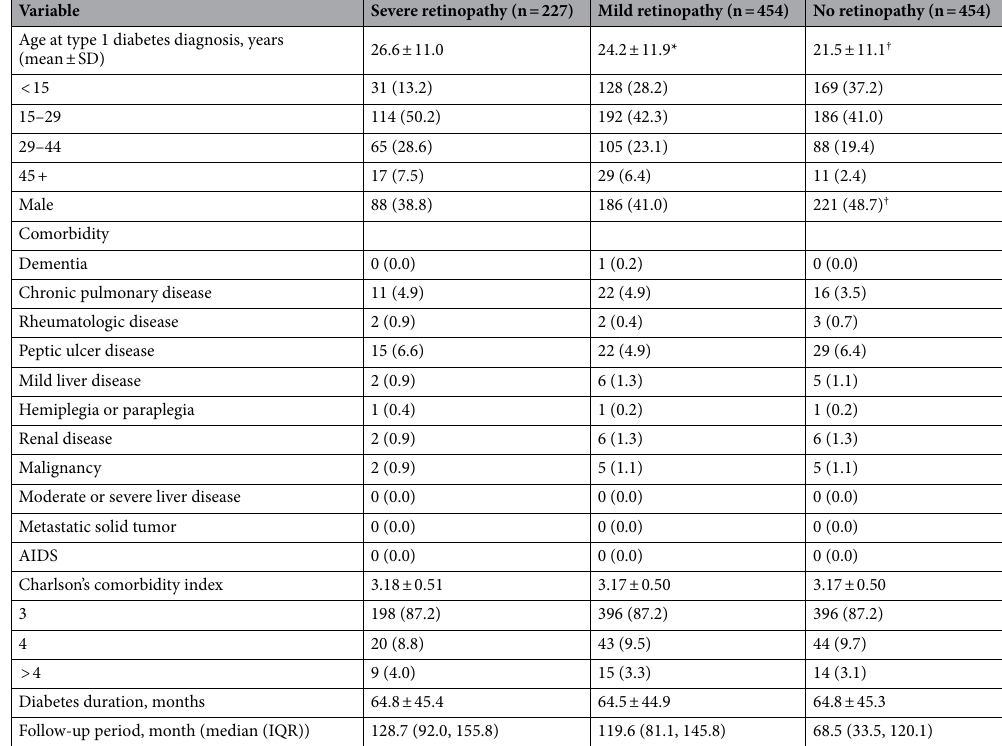
Table 1. Type 1 Diabetes patients divided into mild, severe, no retinopathy groups according to propensity score matching. SD, standard deviation; IQR, interquartile range. Diabetes duration: from T1DM diagnosed until enrol in the study. Follow-up period: from T1DM diagnosed to MACE or ESRD. * p < 0.05, comparison between severe retinopathy and mild retinopathy. † p < 0.05, comparison between severe retinopathy and no